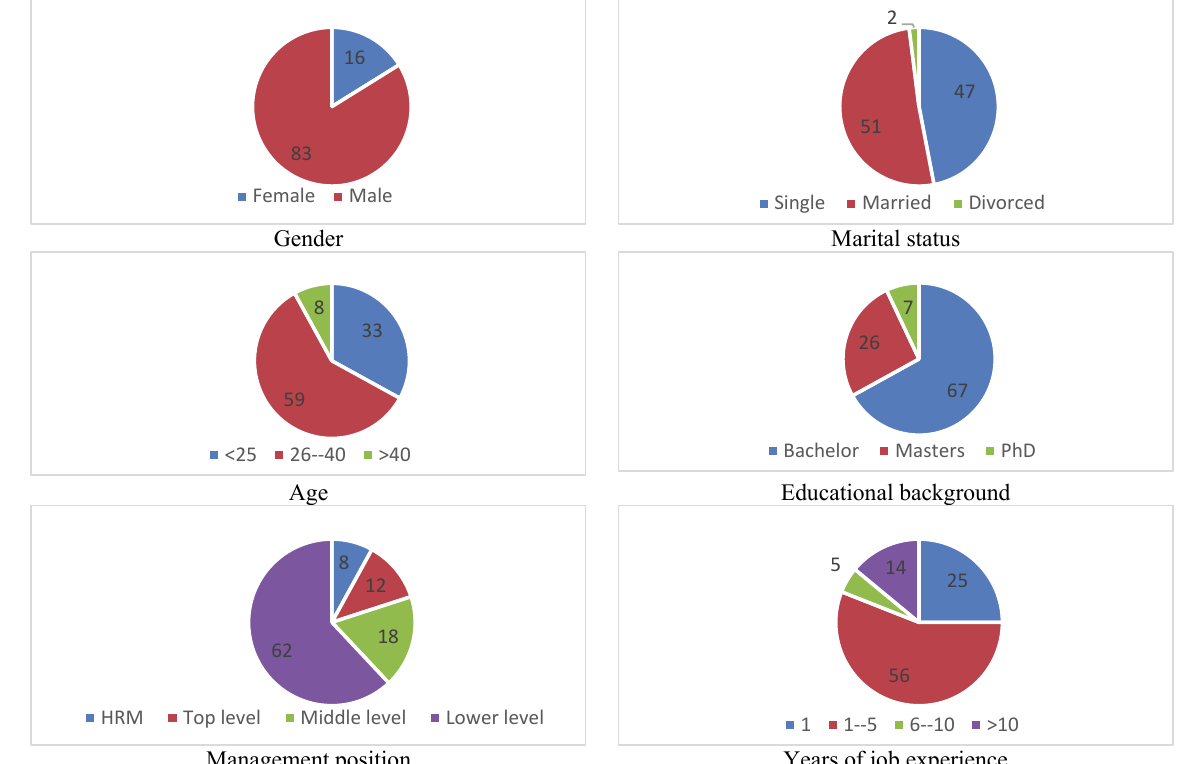
Fig. 2. Personal characteristics of the participants in